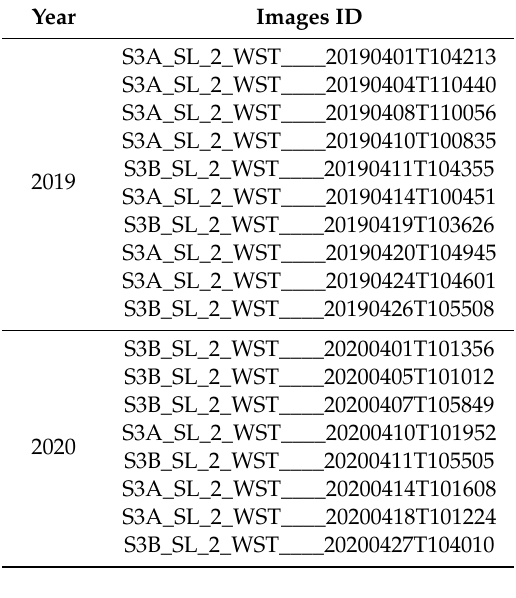
Table 1. Sentinel 3 images. Timing mentioned in images ID is referenced to Greenwich Mean Time (GMT).